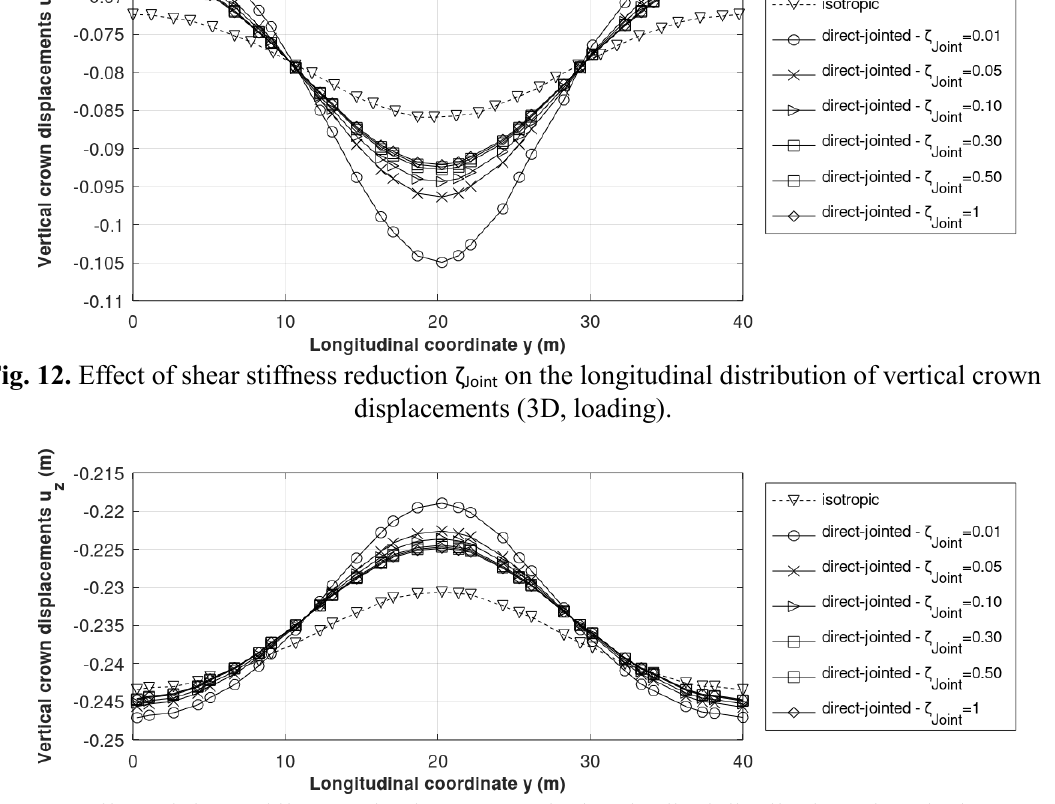
on the longitudinal distribution of vertical crown Joint displacements (3D,